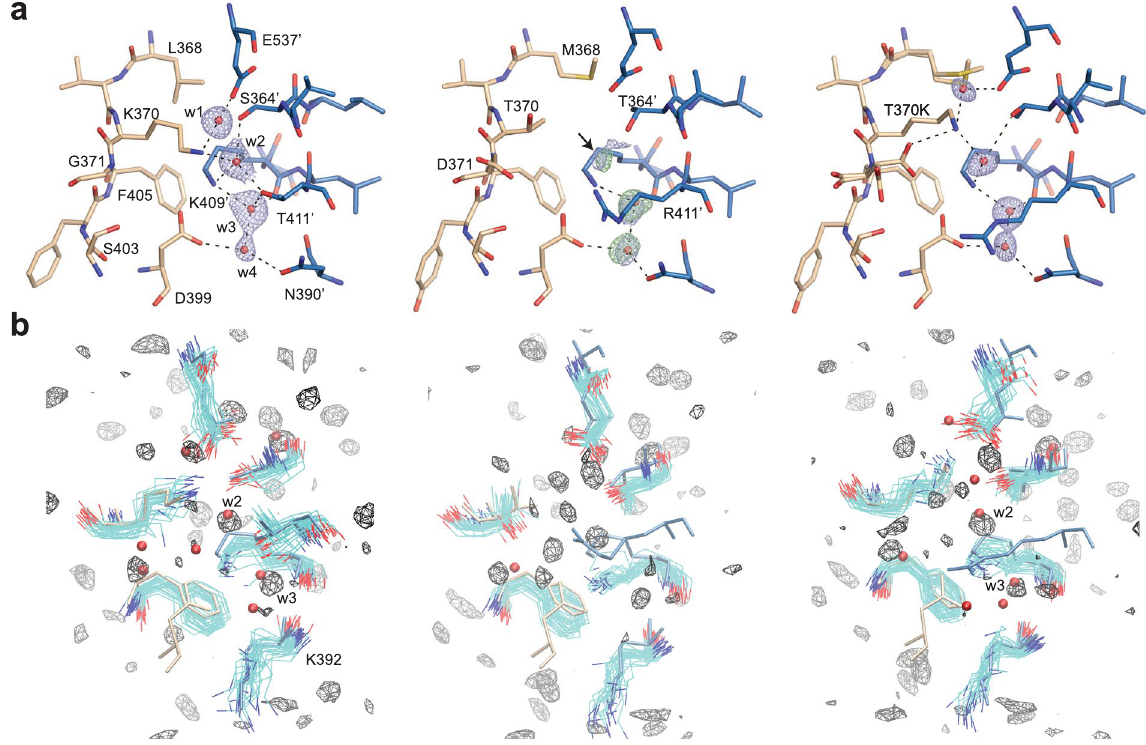
Figure 3. ( a ) Selected residues at the CH3-CH3 interface shown in stick for hsIgG1 (left, PDB ID: 3AVE) 54 , mmIgG2a (middle, PDB ID: 3ZO0 27 from PDB_REDO databank 52 ), and mmIgG2a-T370K mutant. Selected residues in hsIgG1 are labeled. Residues differing in sequence in mmIgG2a compared to hsIgG1 are also labelled. Structures are oriented similarly and opposing CH3 domains are indicated in tan and blue colors. Select water molecules are shown as red spheres (labeled) and hydrogen bonds (3.3 Å cut-off) as dashed lines. Water molecules depicted in mmIgG2a structure were not present in the PDB entry but were added in Coot and refined in real space consistent with available 2mFo-DFc density. 2mFo-DFc densities are shown at a contour of 1 σ carved about water molecules at a distance of 1.5 Å (blue mesh). Additionally, the mFo-DFc density for mmIgG2a is shown at a contour of 3 σ carved about placed water molecules at a distance of 1.5 Å (green mesh). An arrow points to 2mFo-DFc and mFo-DFc contoured as previously carved 1.5 Å about a pseudoatom positioned similarly to water w2 in PDB ID: 3AVE (not shown). mFo-DFc at this position was not visible at a contour of 3.5 σ . ( b ) Side chain and water dynamics from MD simulations. Side chain conformations from the respective crystal structure are shown in licorice with residues D399, F405, T/K370 from one CH3 domain colored tan and E357 ′ , S/T364 ′ , K409 ′ , T/R411 ′ and K392 ′ from the opposing CH3 domain colored blue. Water molecules from respective crystal structures are shown as red spheres. Fluctuations of the side chains in the MD simulation are indicated by overlaying 25 conformations sampled at an interval of 10 ns. For clarity, the fluctuations of the following residues are not shown: D399 for hsIgG1 (left), D399 and R411 ′ for mmIgG2a (middle), and D399 and R411 ′ for mmIgG2a T370K (right). Water occupancy maps contoured at an isolevel of 5 times bulk occupancy are shown in black wire